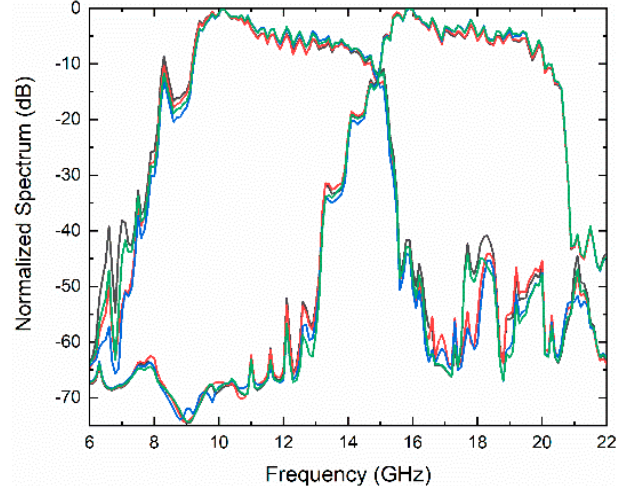
Figure 5. Normalized spectral response of the receiver of the four detected outputs for both frequency bands.